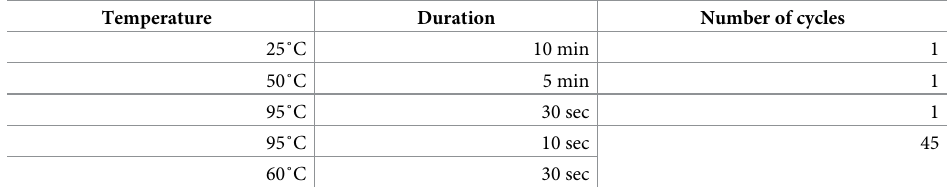
Table 6. Optimized one-step real-time RT-PCR cycling parameters for the MoCO kit.